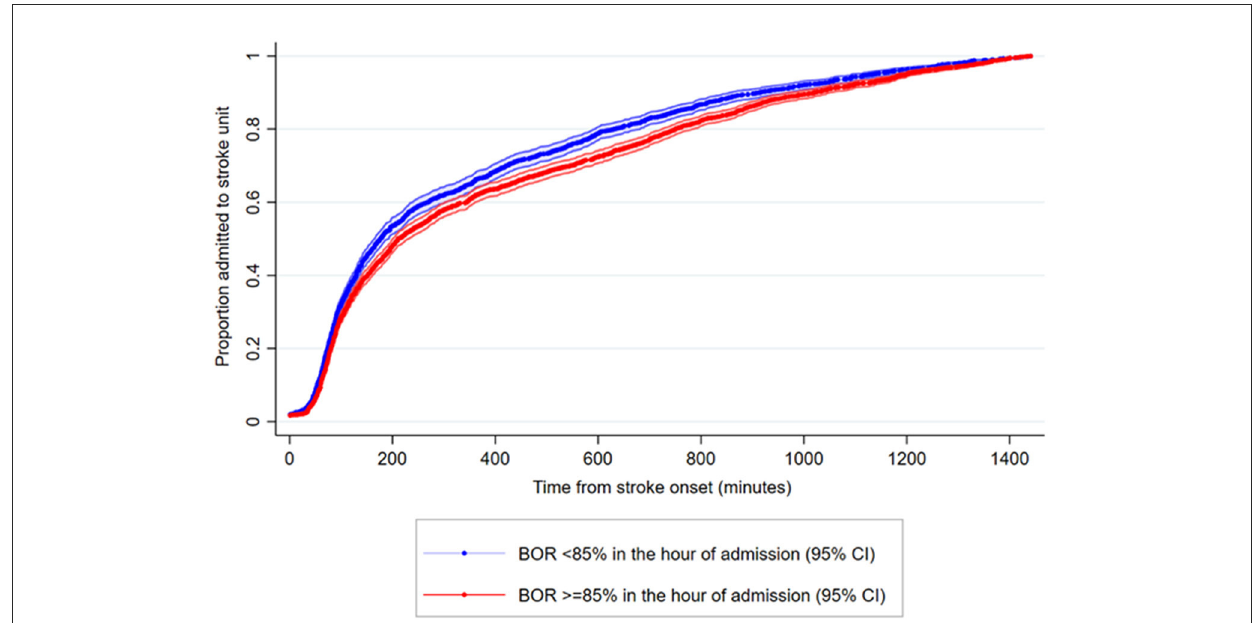
FIGURE2 Proposition of ischemic stroke patients admitted to a stroke unit in relation to time from onset. Cumulative data on time from stroke onset to stroke unit admission in AIS patients stratified by bed occupancy rate ≥ 85% (red curve) or BOR < 85% (blue curve) in the hour of admission. When